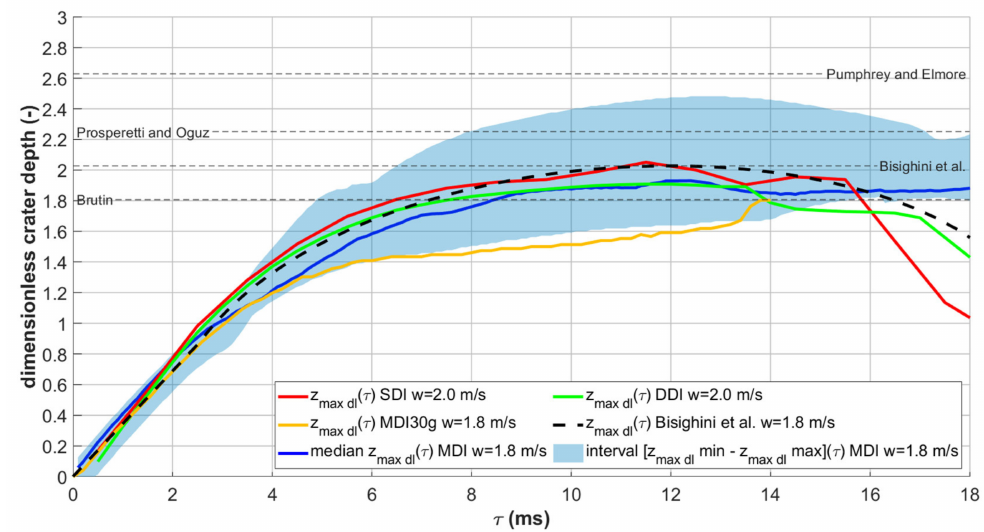
Figure 8. Dimensionless crater depth as a function of time for single, double, and multiple drop impacts at 1.8 m/s. Predictions from some of the most credited literature models are also shown.